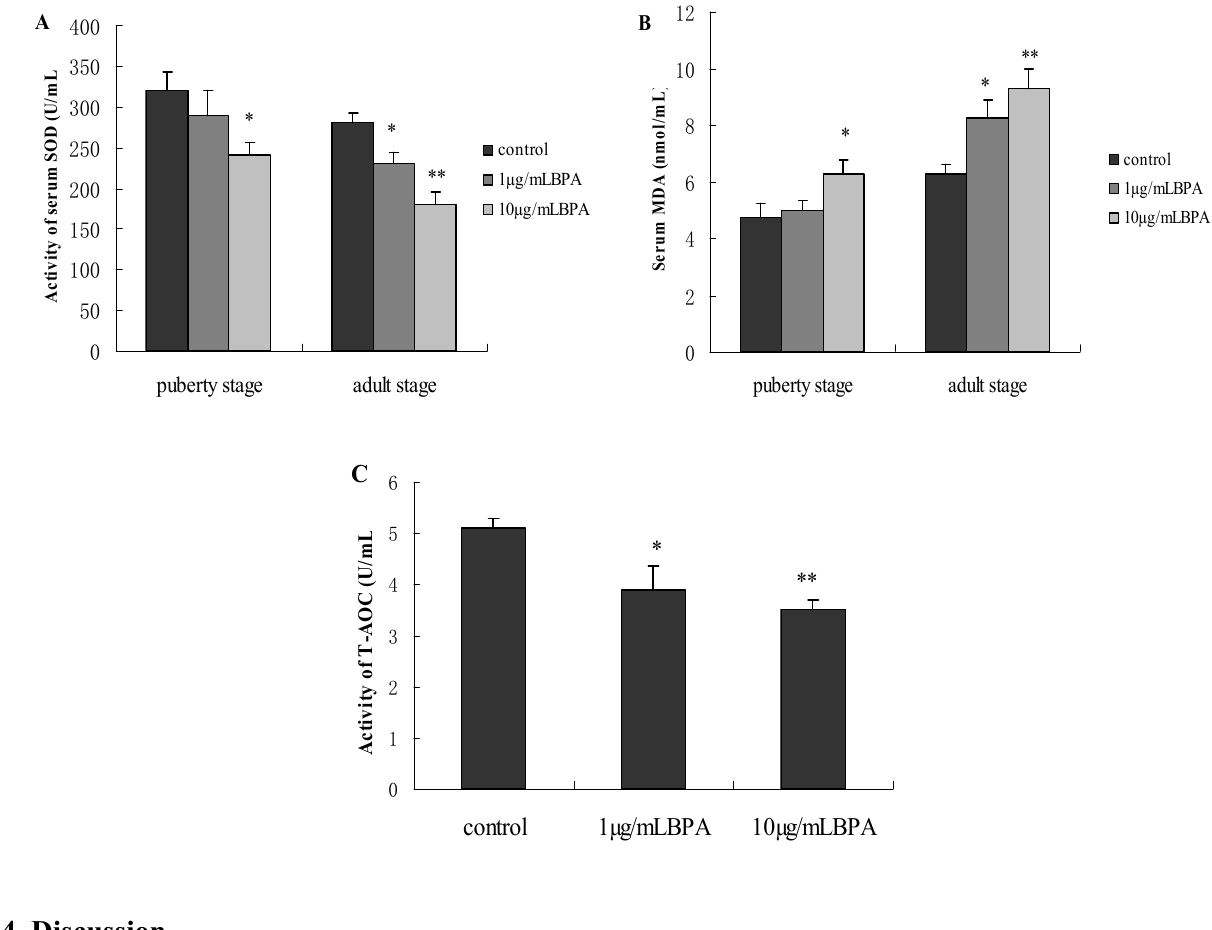
Figure 5. Effects of perinatal exposure to BPA on the parameters of oxidative stress. Pregnant rats ( n = 7/group) were exposed to vehicle or BPA in water at levels of 1 or 10 µg/mL from gestation day 6 through the end of lactation. The levels of serum SOD, MDA and T-AOC were measured by a commercial kit. Values represent the mean ± SE ( n = 7, one from each group). * p < 0.05 and ** p < 0.01 compared with